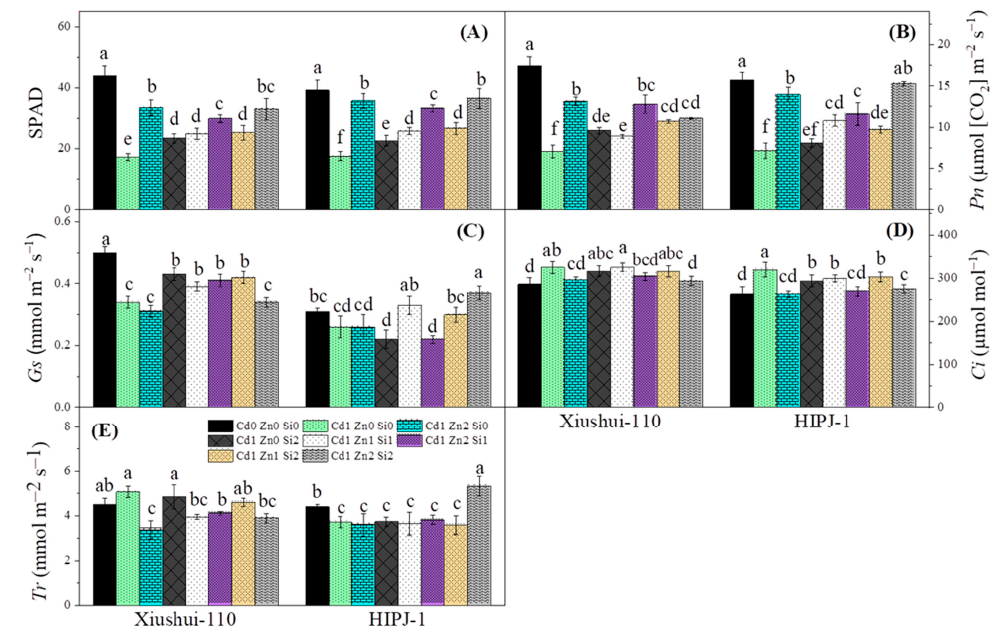
Figure 2. Effects of individual Cd, Zn, and Si treatments and their combination on ( A ); SPAD (soil and plant analyzer development), ( B ); net photosynthetic rate ( Pn ), ( C ); stomatal conductance (Gs), ( D ); intercellular CO 2 concentration ( Ci ) and ( E ); transpiration rate ( Tr ) in two rice genotypes. Legends: Cd0 Zn0 Si0 (CK). Cd0 (0 μ M), Cd1 (15 μ M); Zn0 (0 μ M), Zn1 (1 μ M), Zn2 (10 μ M); Si0 (0 μ M), Si1 (5 μ M), Si2 (15 μ M). Vertical bars represent the means of three independent replicates (±SE). Different letters indicate statistically significant differences at p ≤ 0.05 probability level within the genotype.2.3. Antioxidant Enzyme Assay and Lipid Peroxidation.